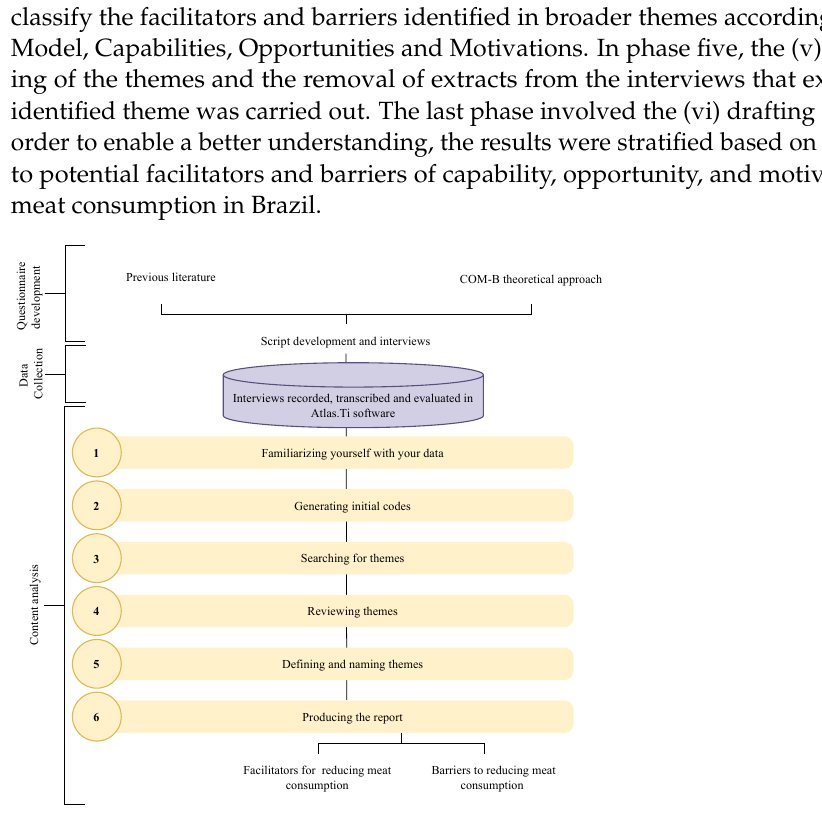
Figure 3. Content analysis in six steps for pattern identification, based on studies (adapted from Braun & Clarke [32].